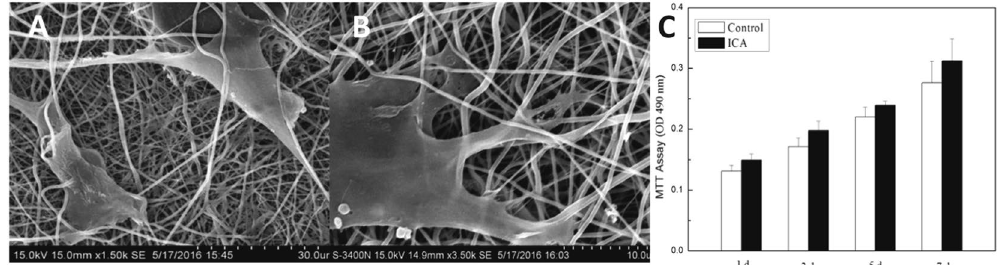
Figure 6. Representative SEM images of BMMSCS–membrane composites after 5 d of culture (Scale bars: ( A) 30 μ m; ( B ) 10 μ m) and propagation of BMMSCs cultured on membrane for different periods ( C ). ICA indicates ICA-SF/PLCL drug-loaded nanofibrous membrane